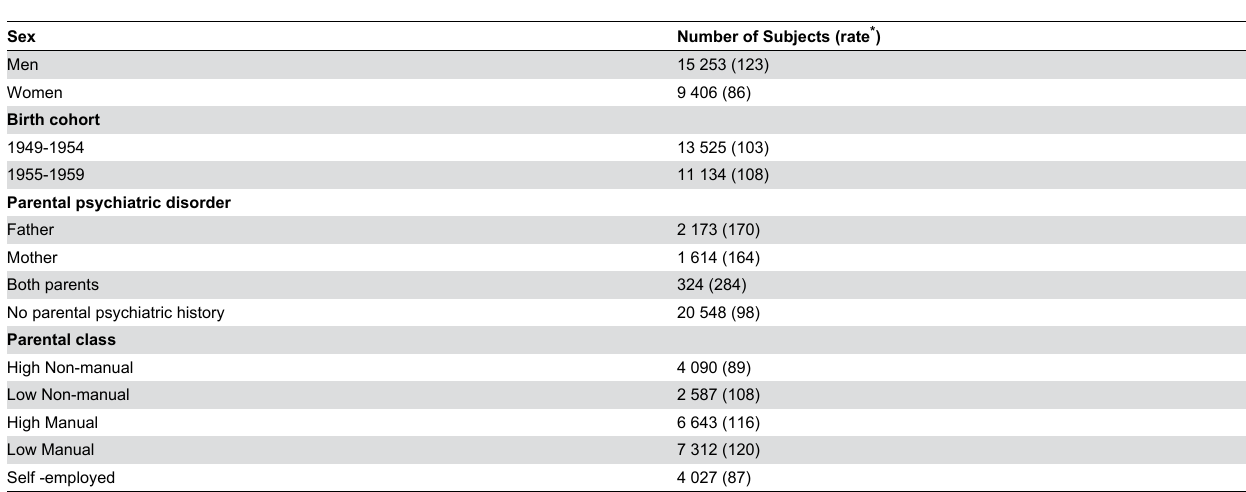
Table 1. Background characteristics of psychiatric